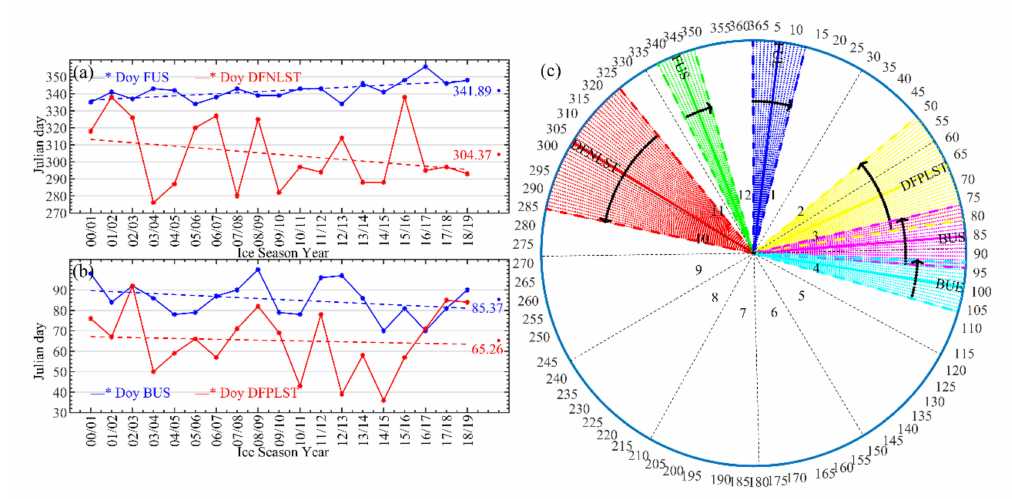
Figure 9. The correlations and trends of DFNLST, FUS, FUE, DFPLST, BUS, and BUE dates for the freeze-thaw cycle of Qinghai Lake during 2000–2018 (( a ). The correlations between DFNLST and FUS, coe ffi cient: − 0.34; ( b ). The correlations between DFPLST and BUS, coe ffi cient: 0.38; ( c ). The range of variations of six critical dates, 1–12 represents for months inside of the circle; 5–365 represents for days outside of the